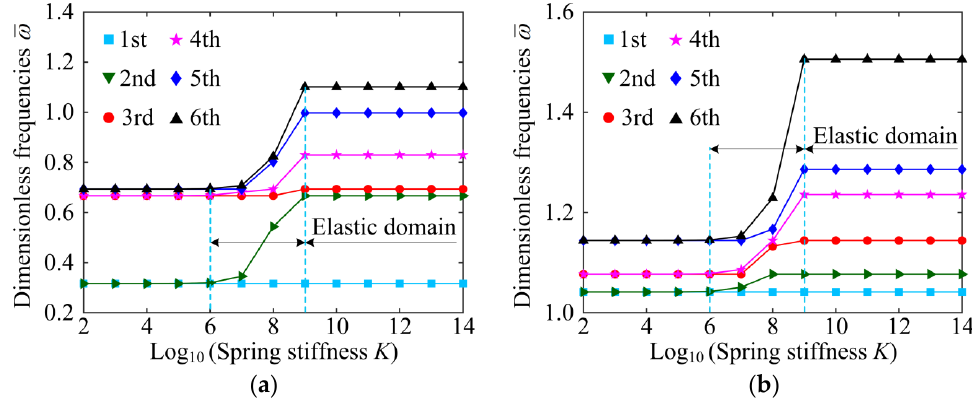
Figure 4. The influences of spring stiffness on first six dimensionless natural frequencies of the GPLRP, two-cylindrical-panel system (Porosity- Ⅰ , GPL A, e 1 = 0.5). ( a ) SSSS; ( b ) CCCC. Table 4. The influences of spring stiffness on dimensionless natural frequencies of the GPLRP, two-cylindrical-panel system (Porosity- Ⅰ , GPL A, e 1 = 0.5). Spring Stiffness Mode